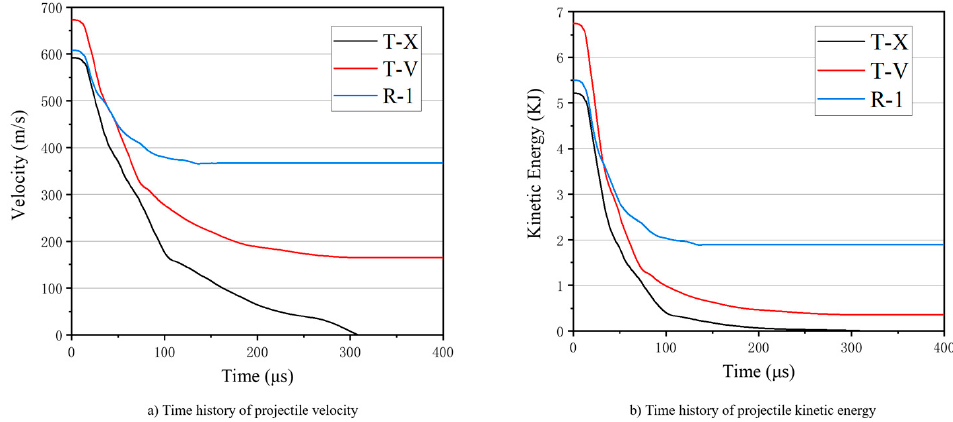
Figure 9. Time history of projectile velocity ( a ) and kinetic energy ( b ) during the penetration.